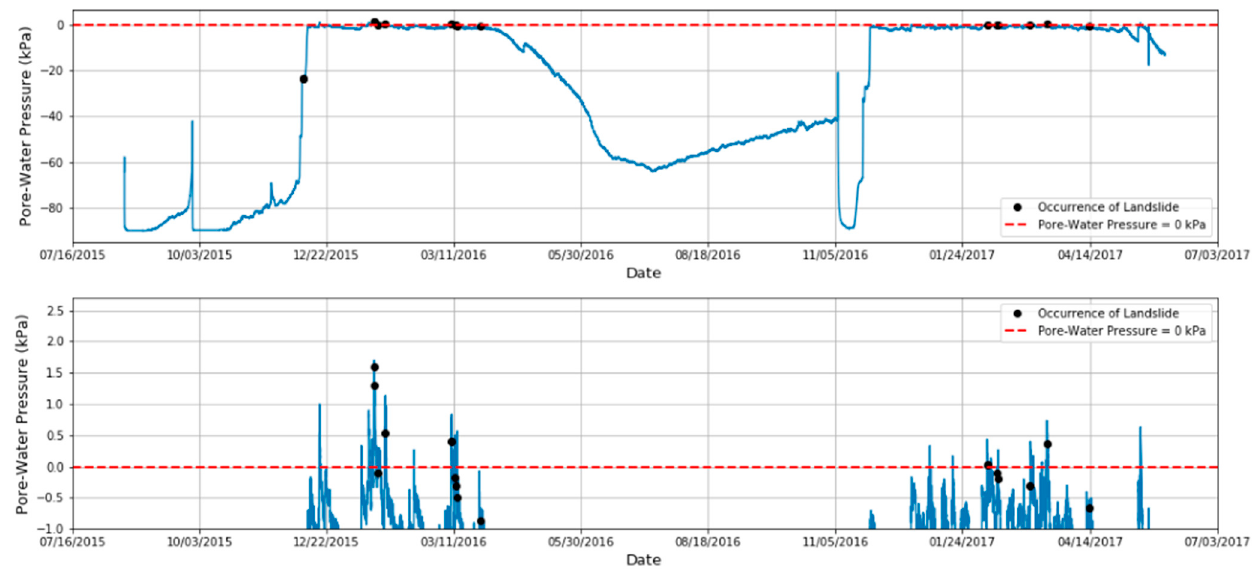
Figure 10. HydroMet output plot showing correlation between landslide occurrences and positive pore water pressure. The total length of time for the data set is shown with the occurrence of a landslide as a dot. The red line signifies where pore pressure is equal to zero, therefore any value above the line would be a positive pore-water pressure. The top plot shows the full range of pore-water pressure values and the bottom is a zoomed in look at the zero-pressure line, highlighting positive and negative values.